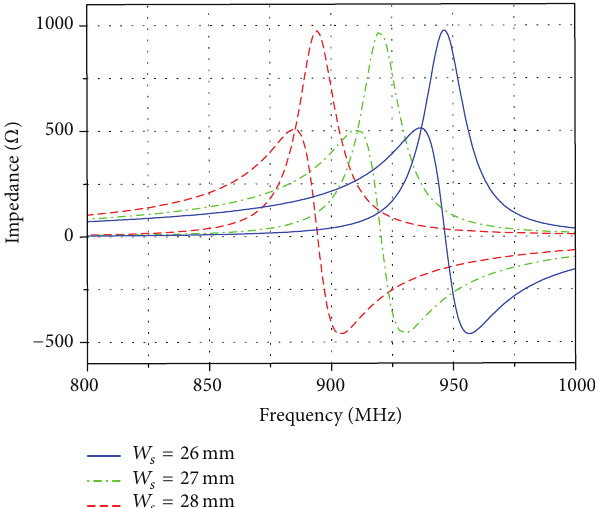
Figure 4: Antenna input impedance for different widths of the slot.